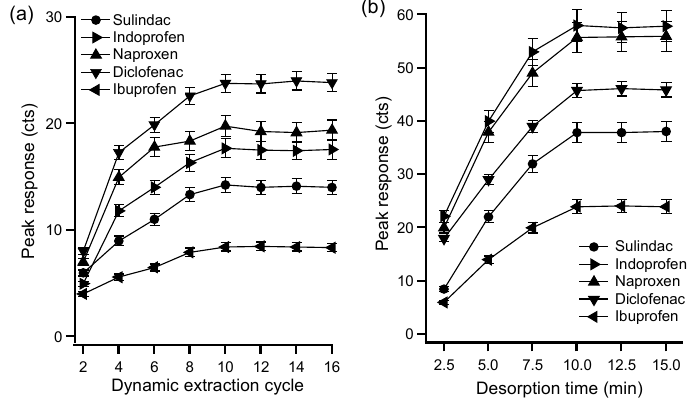
Figure 4. Effect of extraction cycle ( a ) and desorption time ( b ) on peak responses using mixed matrix membrane tip microextraction. Extraction parameters: sample pH, 3.5; addition of salt, 2% (w / v); sample volume, 10 mL; desorption solvent volume, 40 µ L; analyte concentration, 100 ng L − 1 of spiked solution. (Error bars represent standard deviations of results, n = 3).